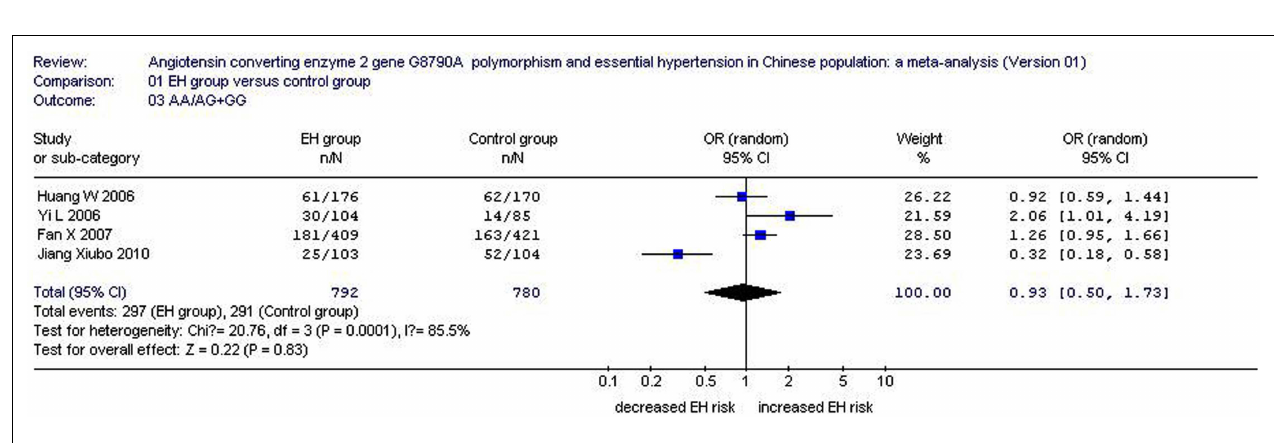
FIGURE 4 | Forest plot of the recessive genetic model of essential hypertension associated with ACE2 G8790A gene polymorphism in female population (AA/GA + GG value of angiotensin converting enzyme 2 gene).